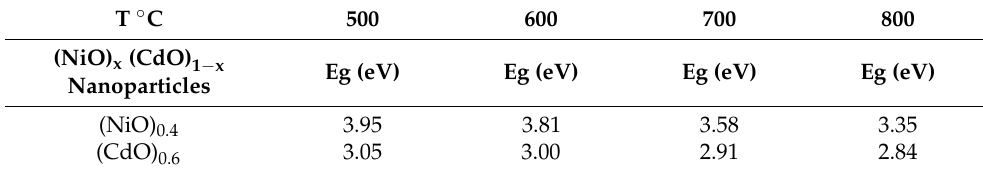
Table 2. Summary of calcination temperatures and bandgaps values.